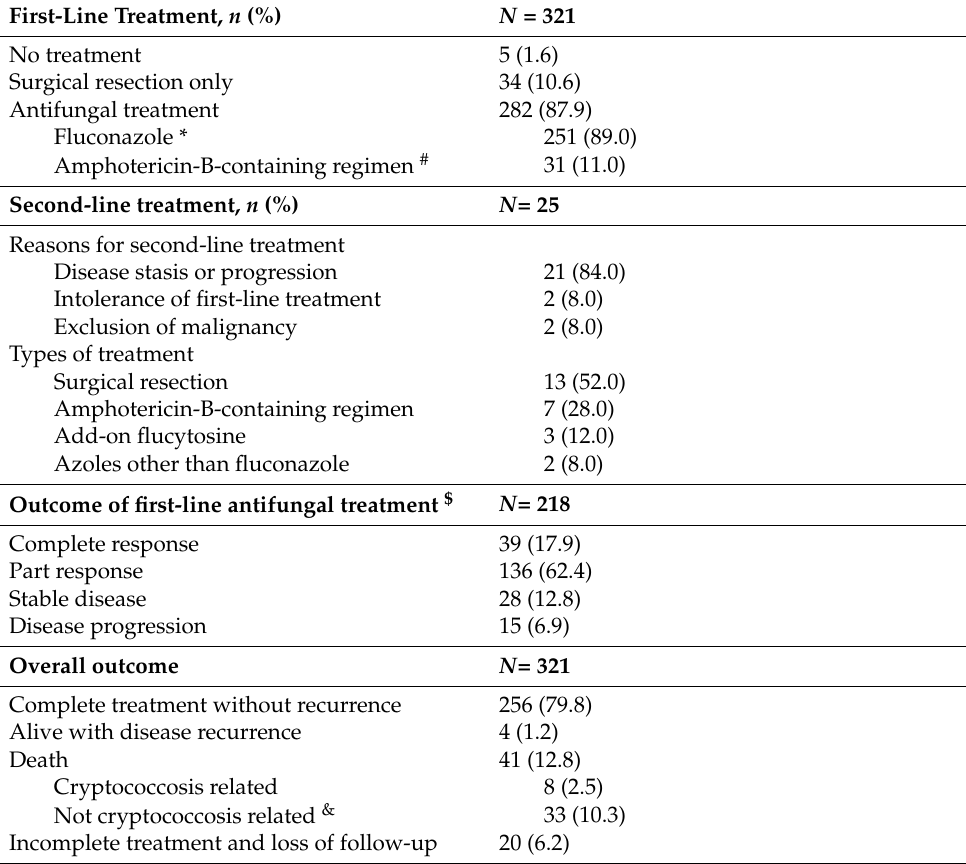
Table 4. The patterns of treatment and outcome of pulmonary